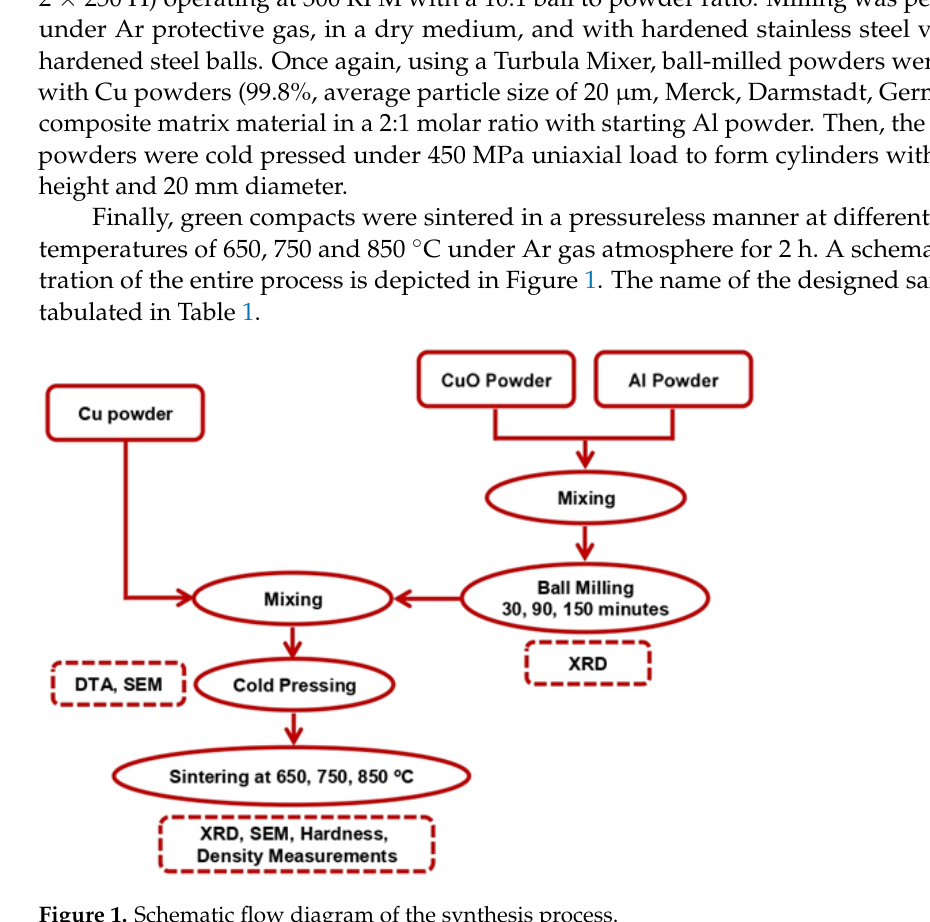
Figure 1. Schematic flow diagram of the synthesis process. Table 1. Synthesis conditions and related code for milled powders and sintered